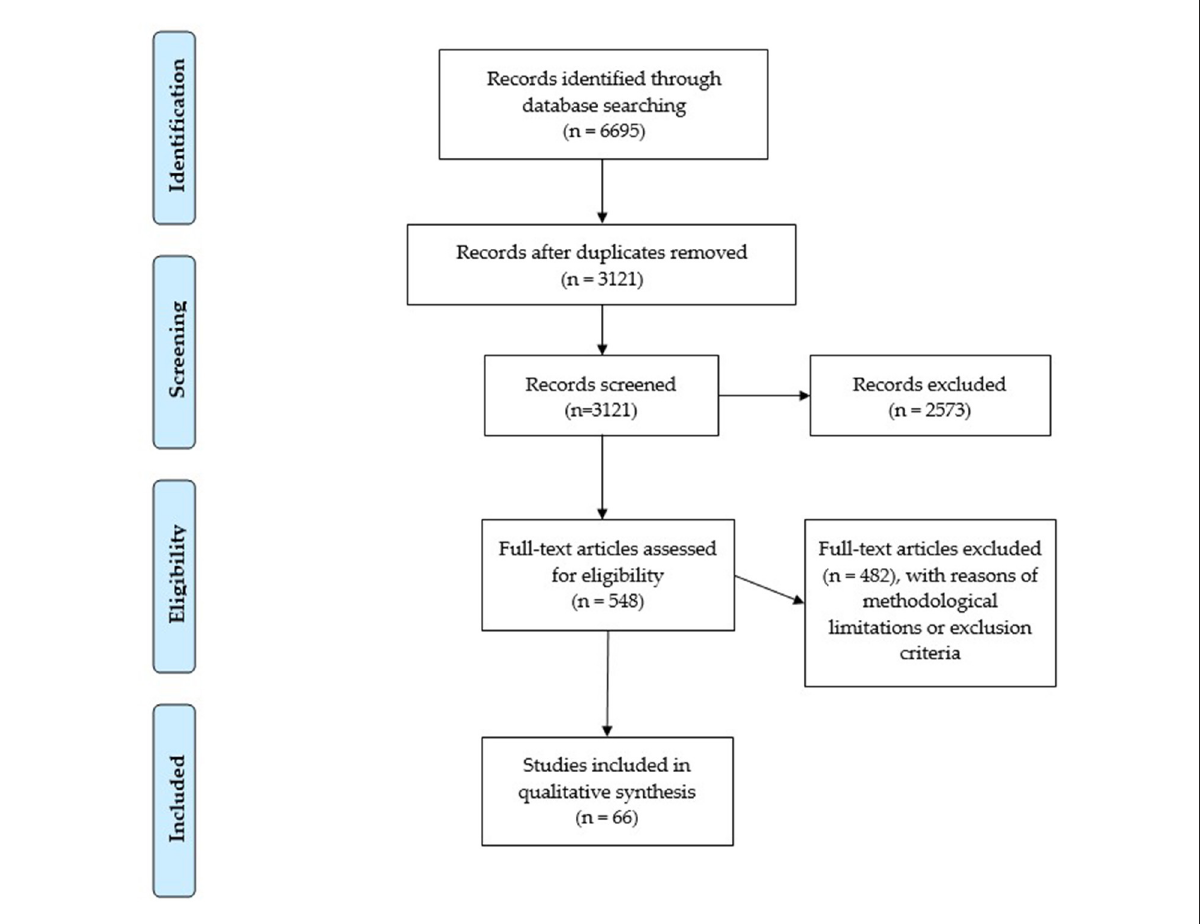
FIGURE1 PRISMA flow